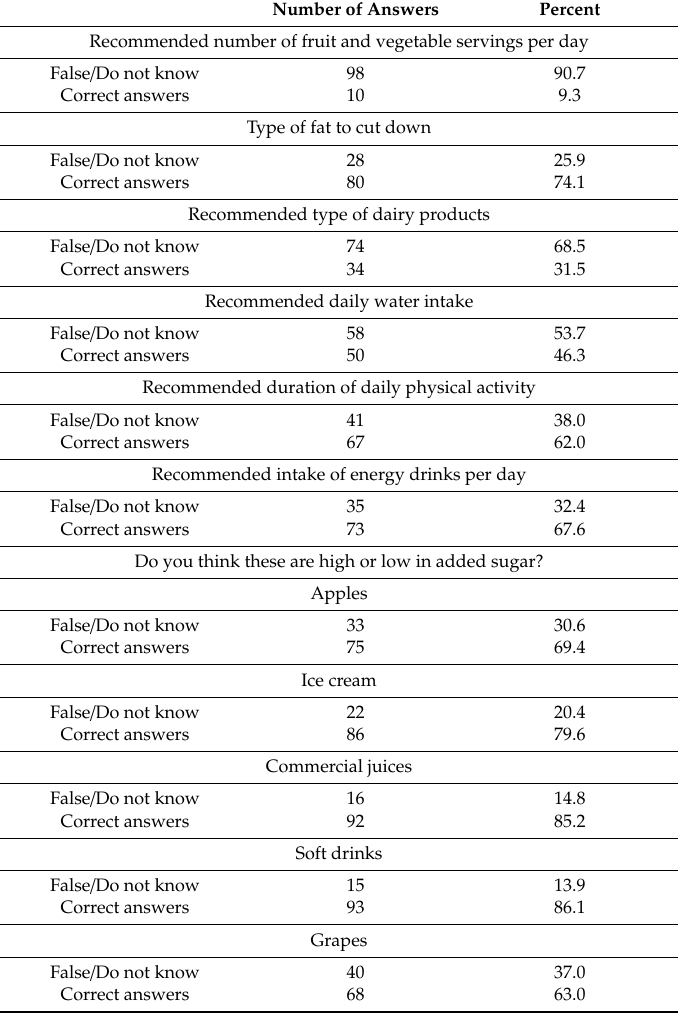
Table A9. Responses to the dietary knowledge questionnaire by parents / caregivers. Number of